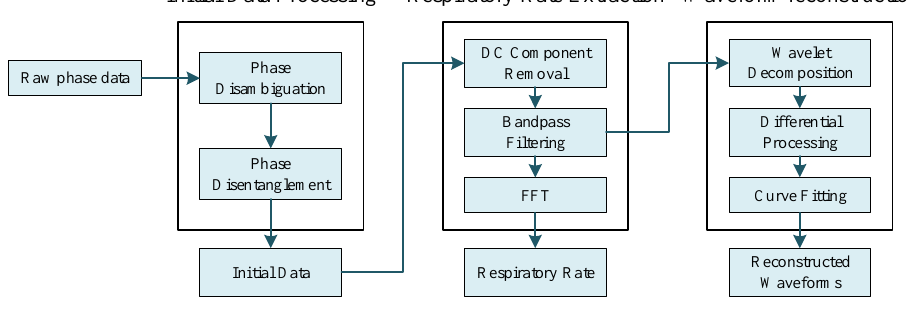
Figure 6. Data Processing Flow.